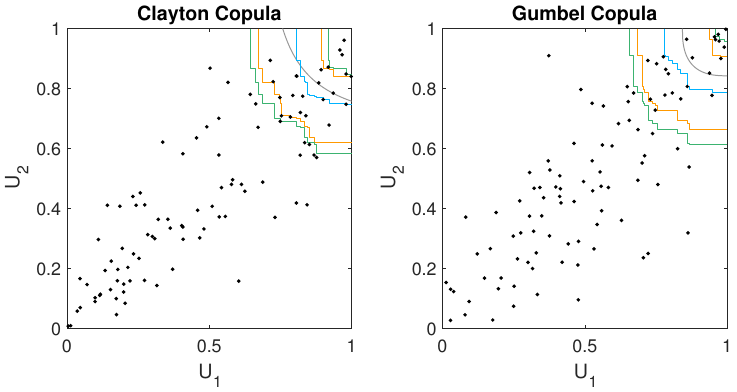
Figure 1. Example of the extended Mammen and Polonik [14] approach. The blue line shows the estimated boundary of the multivariate quantile, the gray line shows the theoretical multivariate quantile boundary for p = 0.9. The orange and green lines depict the confidence regions for α = 0.1 and α = 0.05, respectively. Left Panel: Clayton copula sample with θ = 3 (i.e., Kendall’s τ = 0.6) and n = 100; Right Panel: Gumbel copula sample with θ = 2.5 (i.e., Kendall’s τ = 0.6) and n =